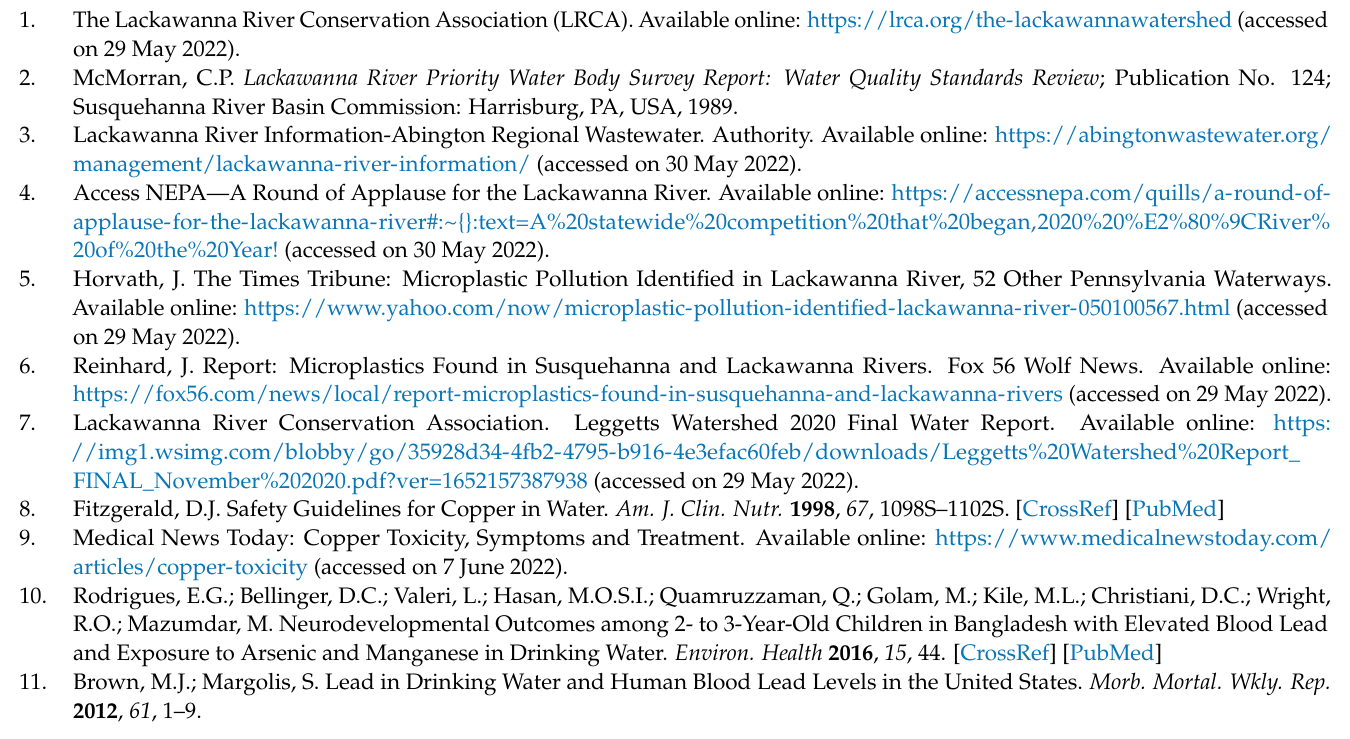
for copper; Figure S3: Calibration curve for lead; Figure S4: Calibration curve for zinc; Figure S5: Calibration curve for manganese; Figure S6: Calibration curve for iron; Figure S7: Calibration curve for